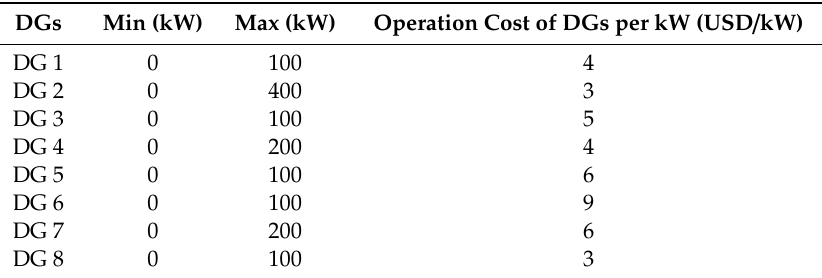
Table 5. Parameters of